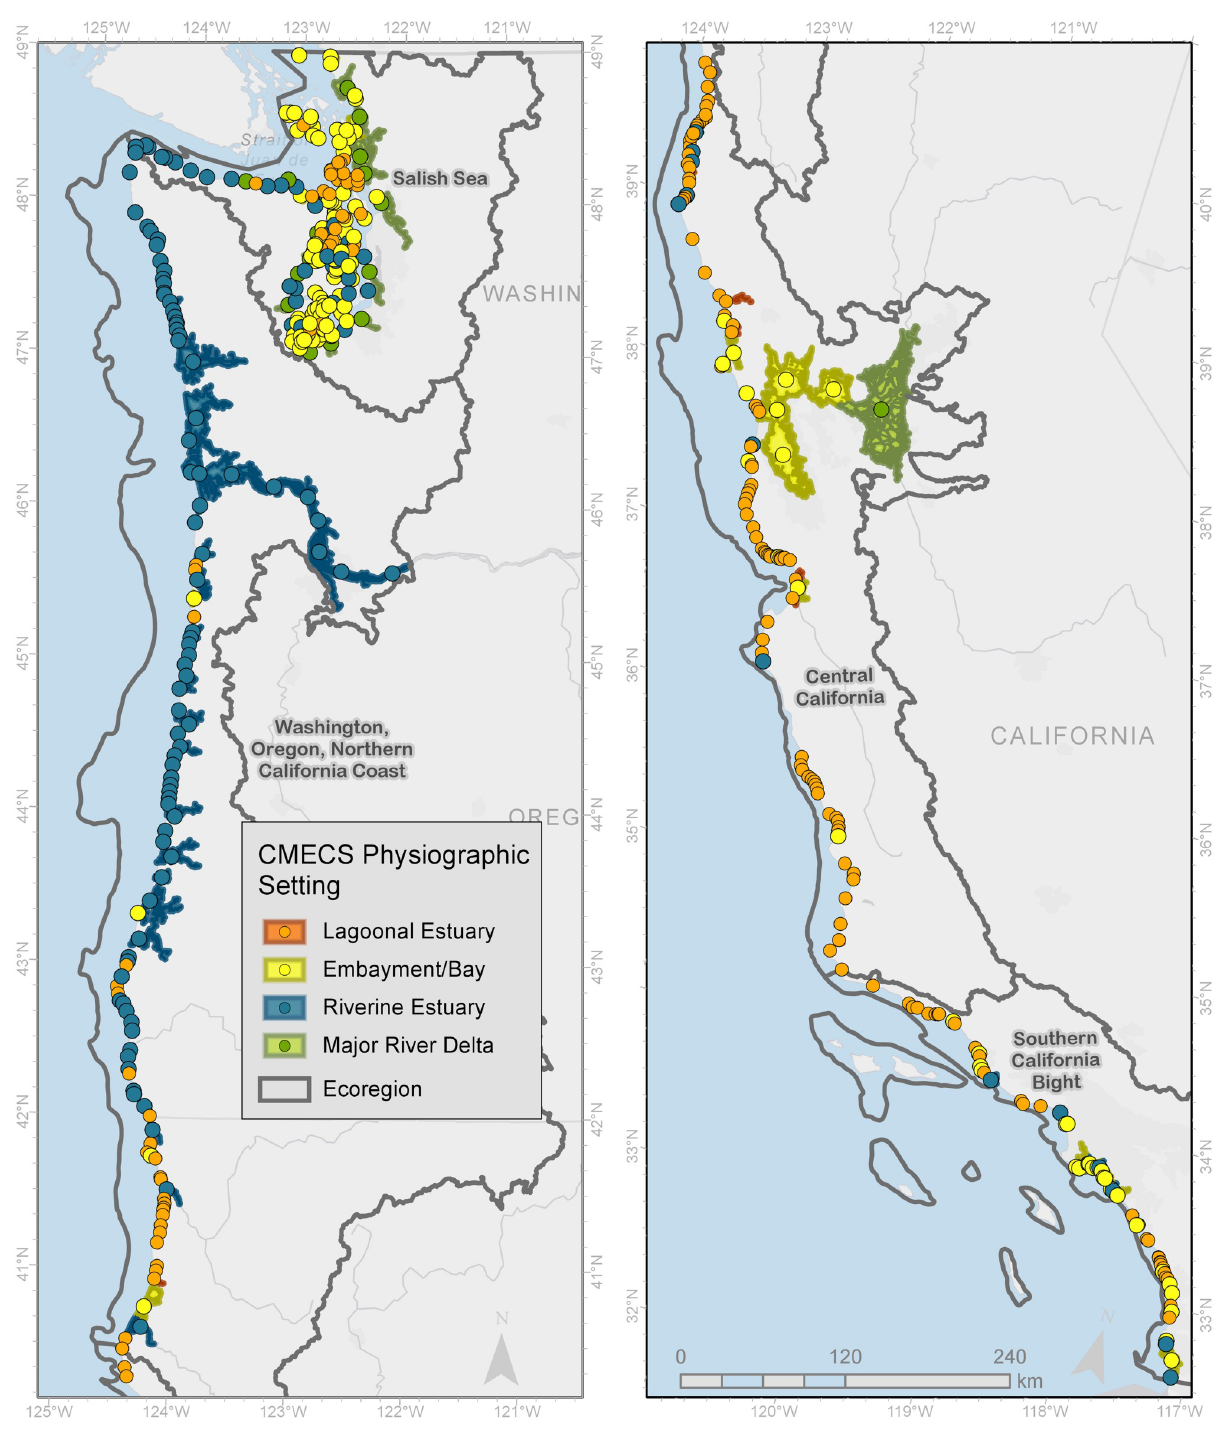
Fig 6. Location and physiographic type of 444 estuaries in four ecoregions of the Pacific Coast. Individual estuaries are denoted by circles of different colors corresponding to physiographic type. For larger estuaries, the entire polygon is shaded with the same colors.